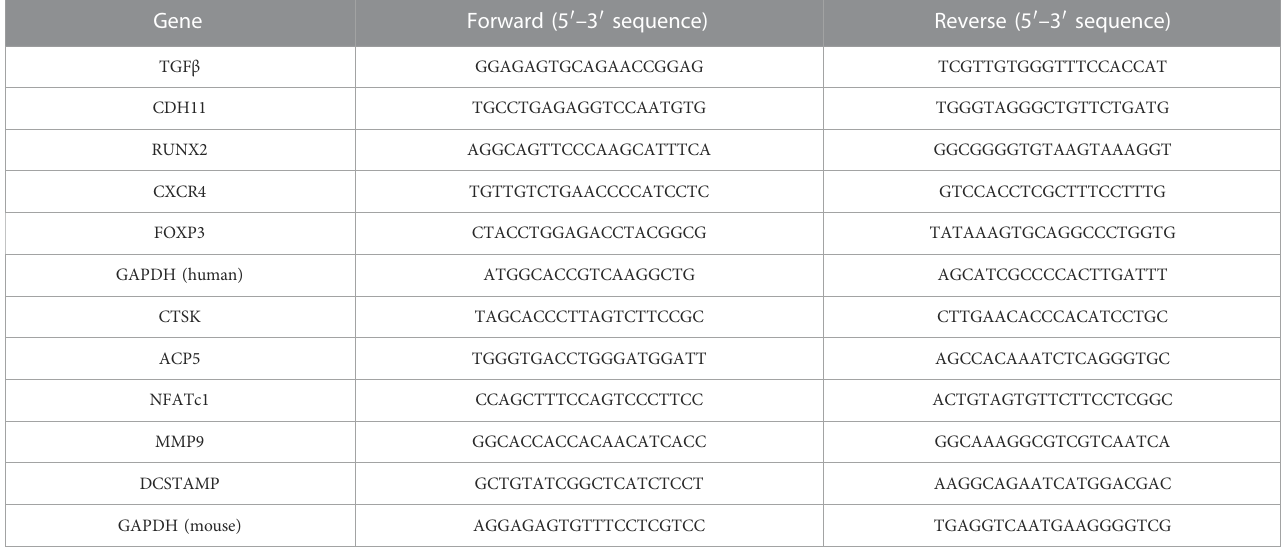
TABLE 1 A List of primer sequences used for RT-PCR in the study. Gene Forward (5 ′ – 3 ′ sequence) Reverse (5 ′ – 3 ′